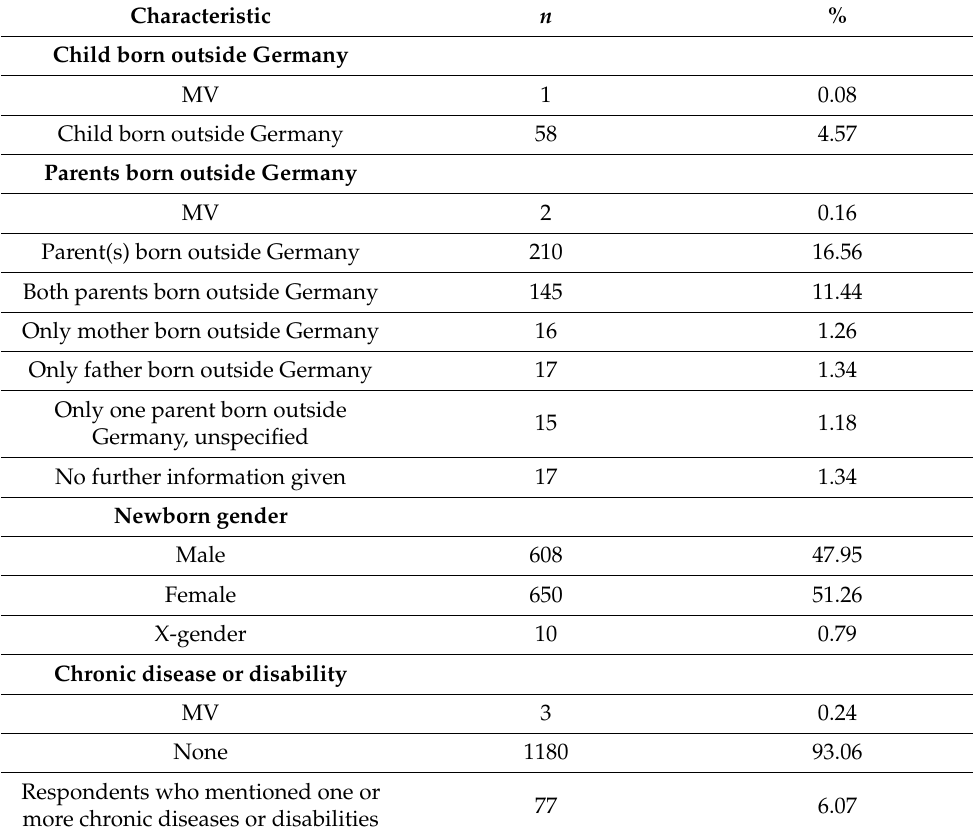
Table 2. Characteristics of the sample ( n = 1268). MV = missing